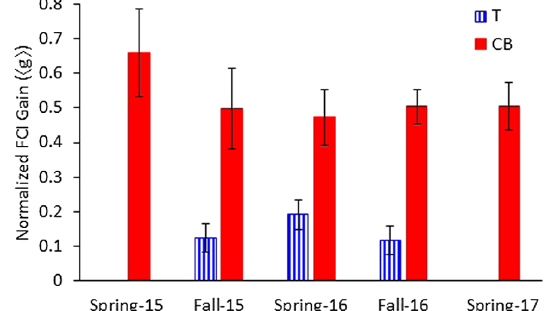
FIG. 6. Comparison of changes to the conceptual understanding due to the instructional process, as measured using the normalized FCI gain ( h g i score). The height of the vertical bars indicate h g i score for each semester listed along the horizontal axis. The striped columns represent the T class and the solid columns represent the CB class. The h g i score of the learners who participated in the CB model instructionsare ∼ 3 times higher than that ofthe learners who participated in the traditional instructional